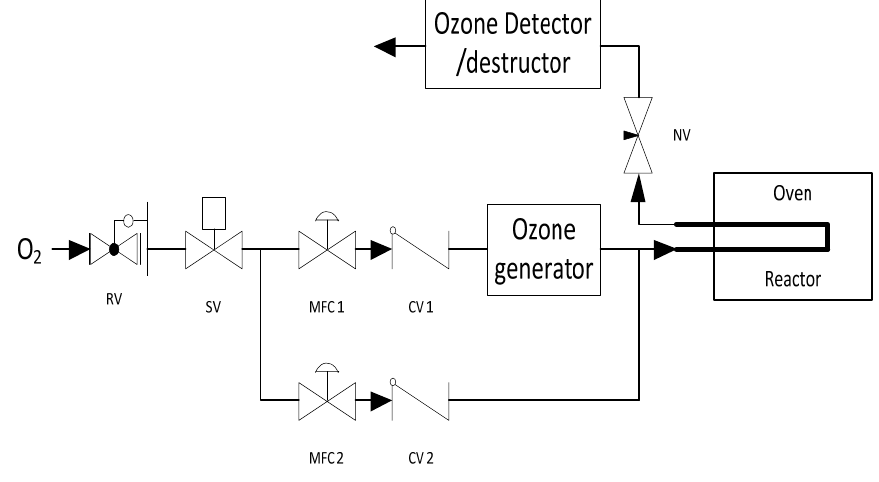
Figure 11. Scheme of the ozone setup.